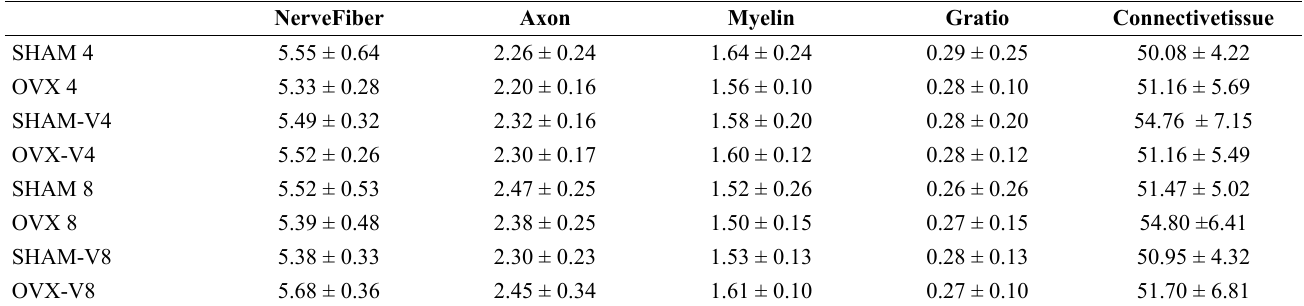
Table 2. Diameter of nerve fiber, axon and myelin sheath (μm), G ratio and percentage of connective tissue of the sciatic nerve of Wistar rats